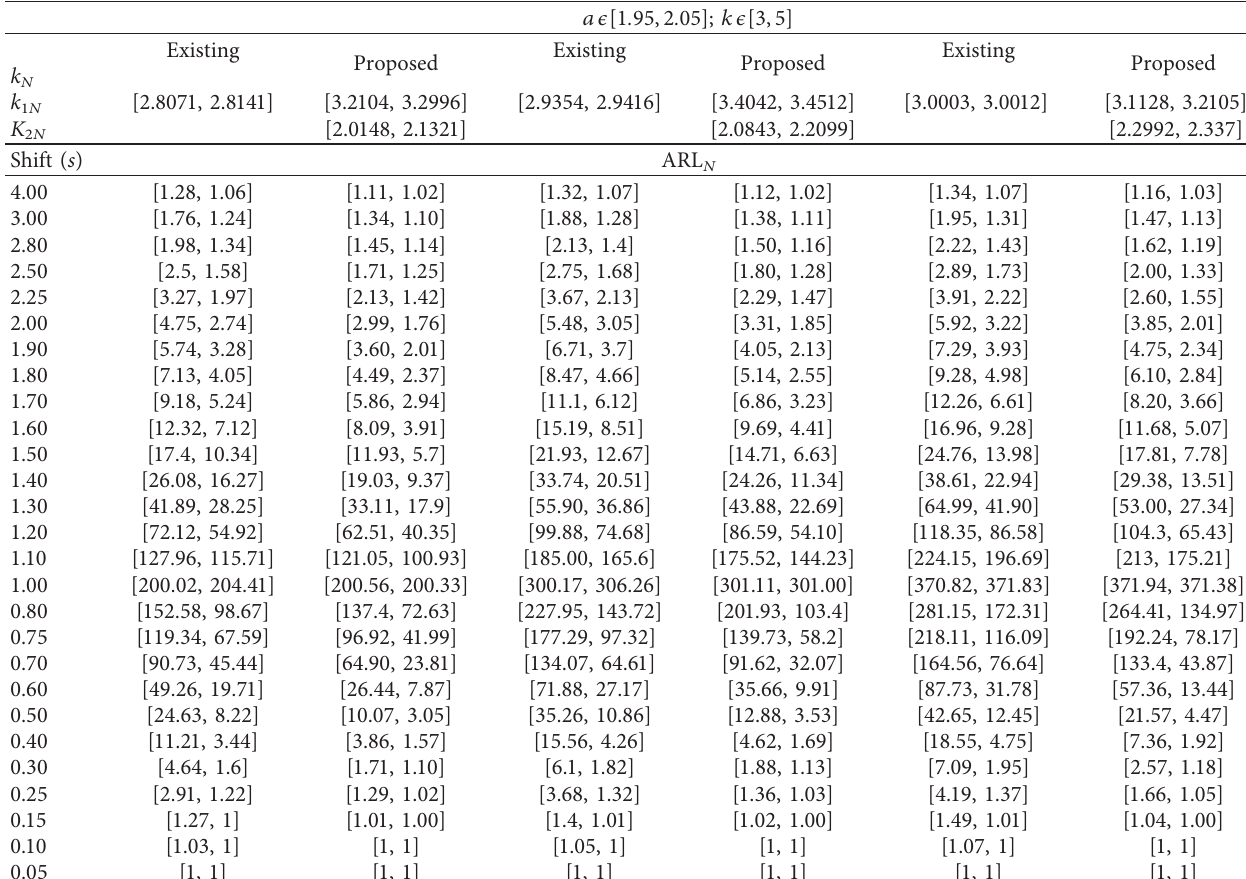
Table 5: The NARL values of the proposed and the existing charts when a ϵ [ 1 . 95 , 2 . 05 ] and k � 3 ,